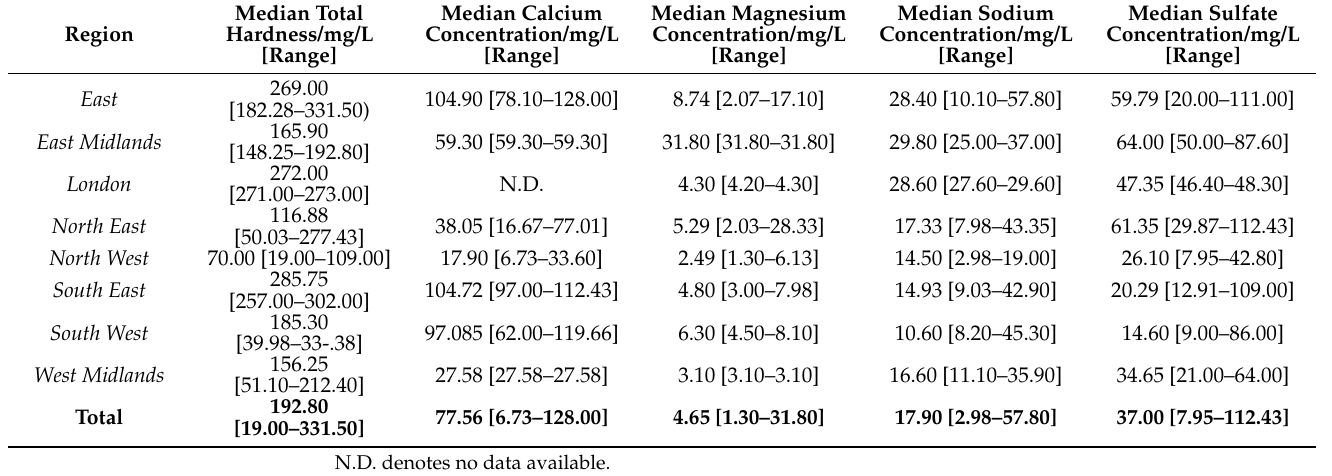
Table 3. Comparison of water composition by region in England.